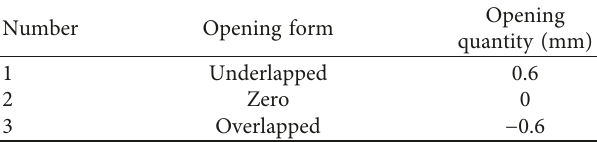
Table 2: Reversing valve